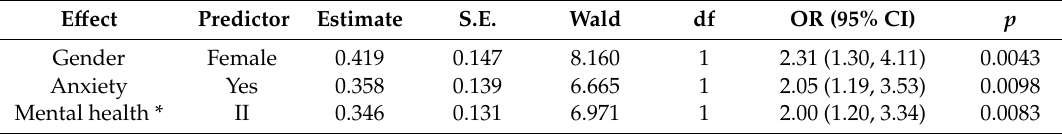
Table 16. Prediction of sleep bruxism (SB) aggravation in